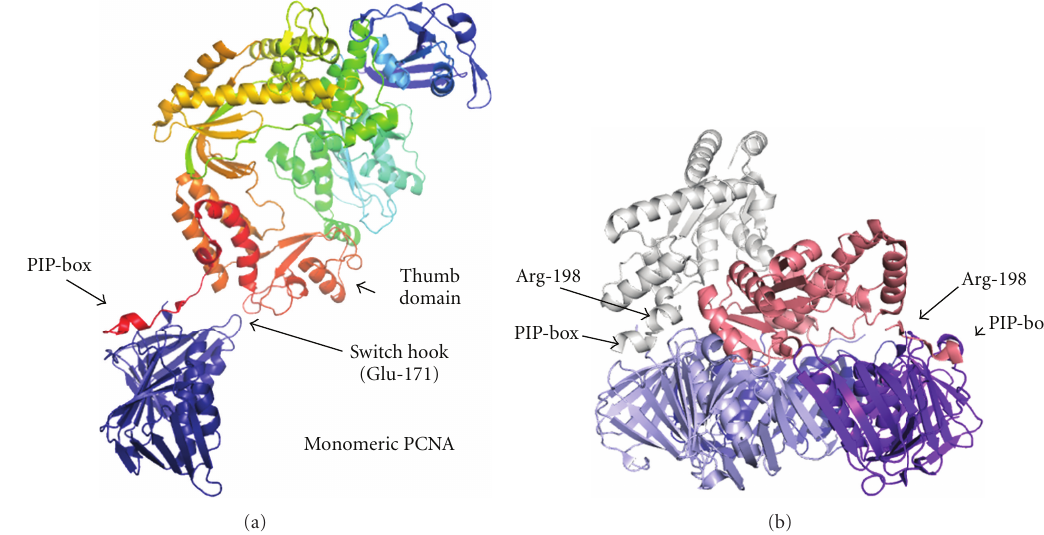
Figure 3: (a) Interaction of PfuPol with a monomeric mutant form of PfuPCNA (3A2F) [29]. The interacting proteins are shown coloured by spectrum from the N-terminus (blue) to the C-terminus (red). (b) Interactions of AfuRNase H with AfuPCNA (3P83). Three protein chains are bound in the structure, for clarity chain D has been removed. The PCNA ring is coloured purple, light, and dark blue. The chain occluding the central pore is coloured in salmon, and one of the two chains oriented away from the pore is coloured grey. The position of the key interacting residue AfuRNase Arg-198 is indicated